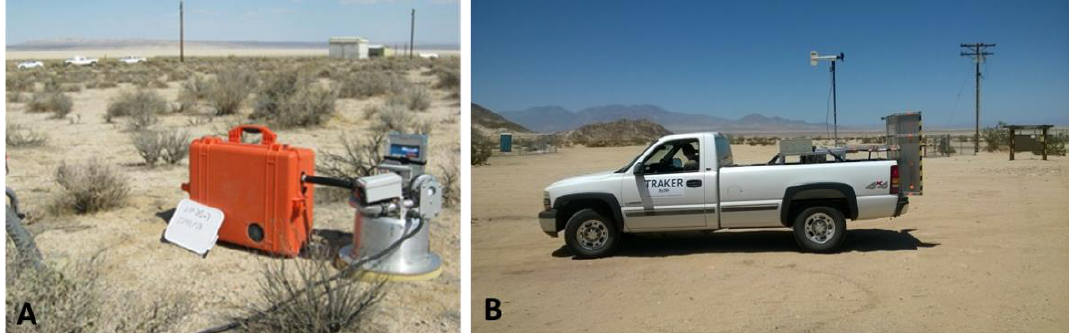
Figure 5. PI-SWERL ® includes a cylindrical chamber that allows for recreating surface wind shear and measuring the resultant dust emissions. The orange case contains filter sampling apparatus with PM10 size selective cyclone ( A ). TRAKER TM was developed as a tool to measure emissions of particulate matter as a result of vehicular travel on unpaved roads ( B ).